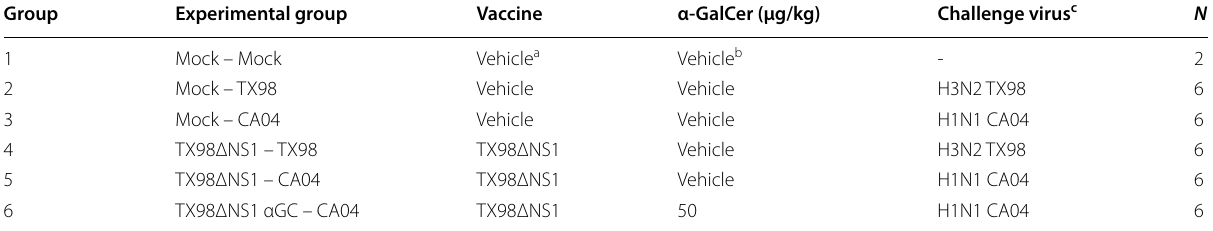
Table 2 Experiment 2 setup